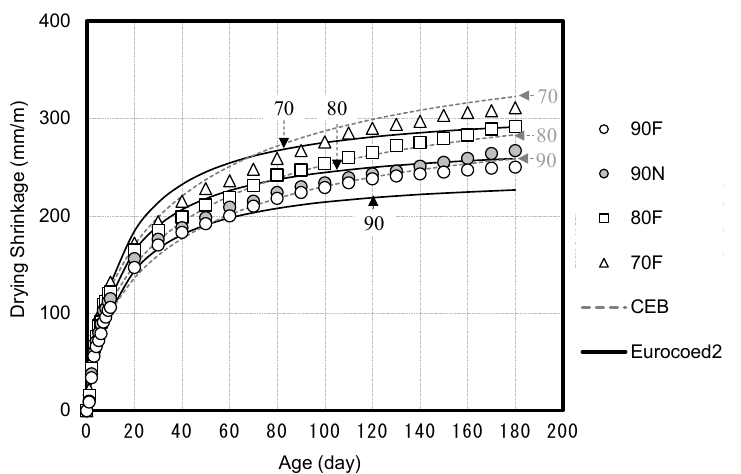
Figure 9. Drying shrinkage of high-strength concrete and code comparison.